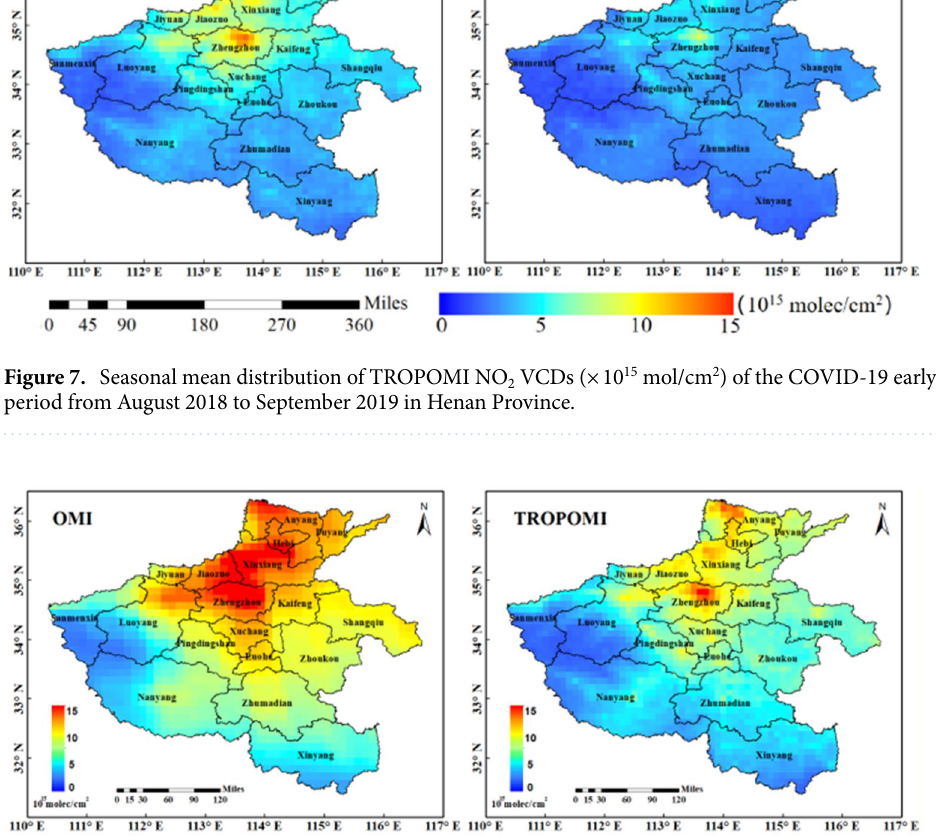
Figure 8. Annual mean distribution of tropospheric NO 2 VCDs (× 10 15 mol/cm 2 ) of the COVID-19 early period from September 2018 to August 2019 in Henan